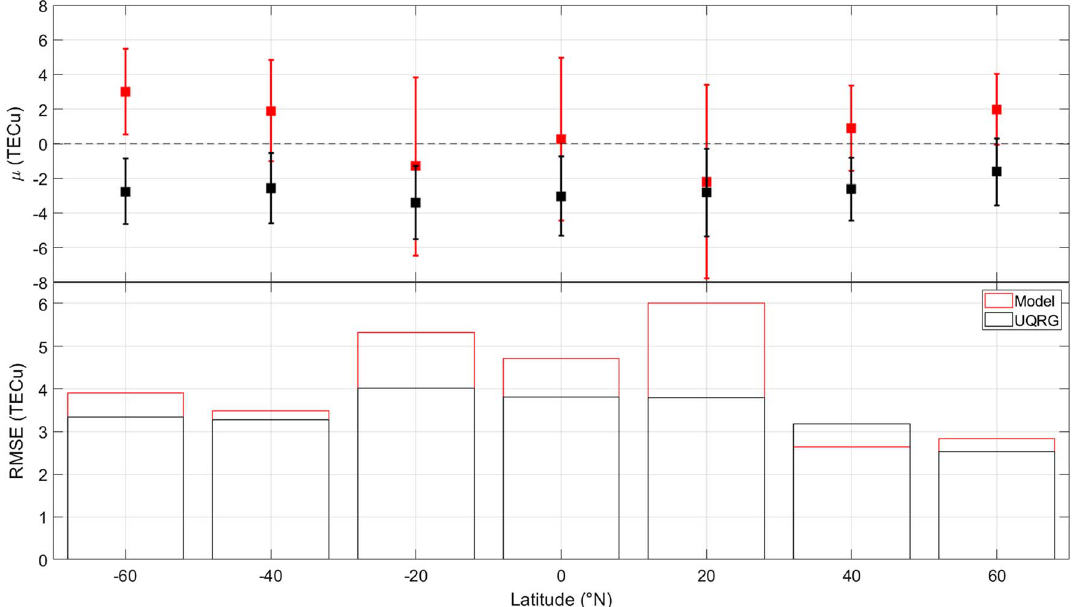
Fig. 15. Latitudinal dependence of the performance against JASON-3 for 08 February 2018 of the Long-Term forecasting model (red) and of the UQRG product (black). Top plot: mean difference with JASON-3 vTEC measurements and the error bar is the 1-sigma spread. Bottom plot: RMSE of the difference.